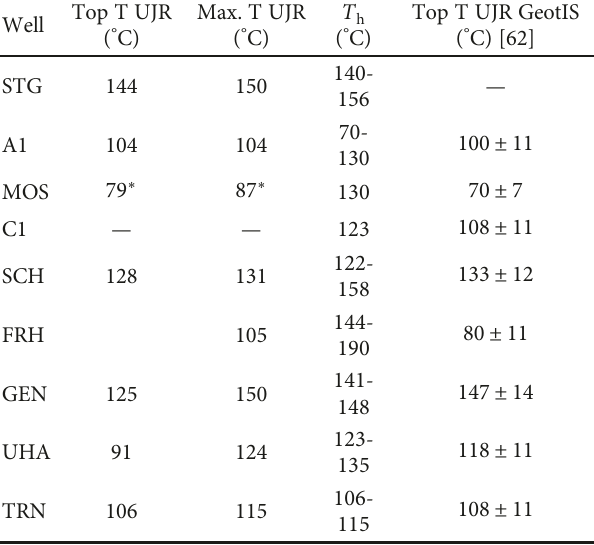
Table 5: Temperature measurements of the recent reservoir temperatures from unpublished borehole